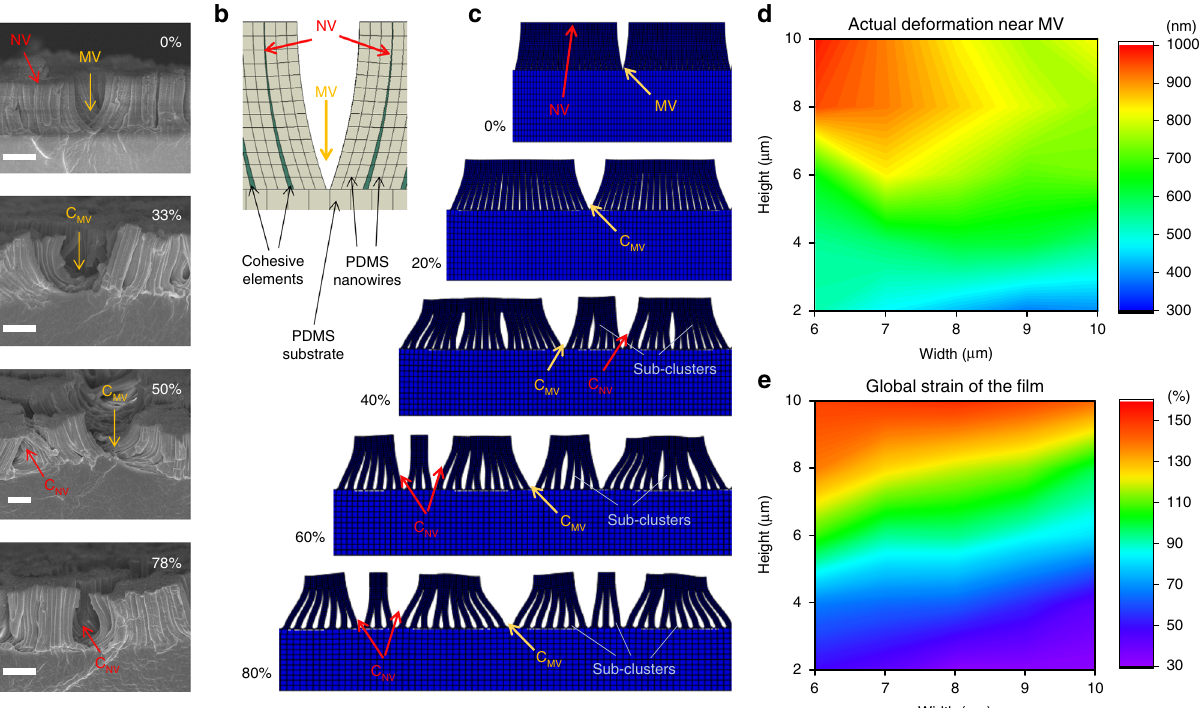
Fig. 2 Simulation of cracking of nanowire-structured surfaces guided by MVs and NVs. a SEM images of cracking induced by MVs (yellow arrow) and NVs (red arrow) of Pt fi lms (scale bar, 2 μ m). C MV (yellow arrow) and C NV (red arrow) represent cracks initiated from MVs and NVs. b Key features of nanowire assembly in FE modeling. c Evolution of hierarchical assembly of 4- μ m-length nanowires as a function of strain (See Supplementary Movie 2). d , e In fl uence of nanowire length and cluster size on ( d ) MV-induced cracking or ( e ) global strain of the nanowire-structured